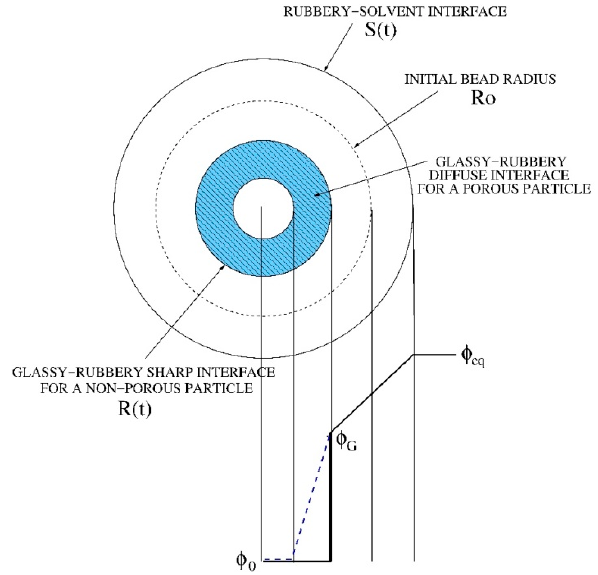
Figure 1. Schematic representation of moving fronts and solvent concentration profiles in a swelling process of a dry spherical bead. The two cases of a non-porous and a highly porous particle (blue dotted line) are shown.